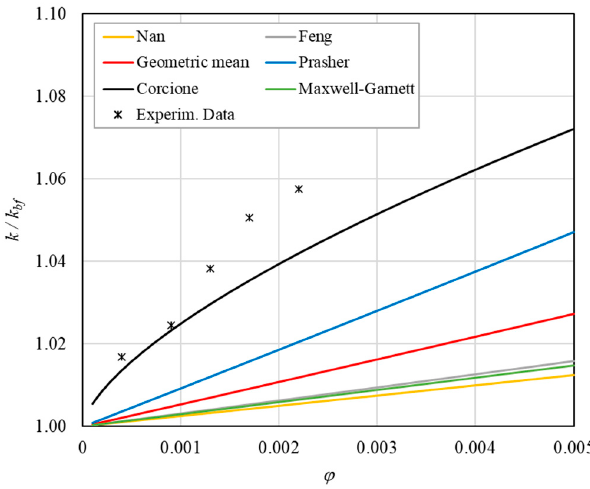
Figure 11. Increase in thermal conductivity versus volumetric content for engine oil (Castrol Magnatec 10W40)—Alumina (d = 50 nm) at 40 °C.